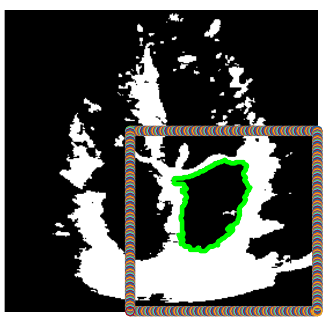
Figure 2. Binarized version of the combined frame, after finding a large contour (green) within the box defined in the bottom right corner of the